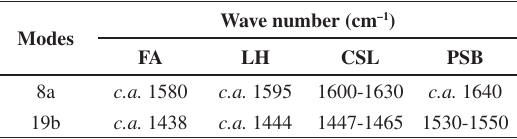
Table 2. Pyridine bands adsorbed on the solid surface according Benvenutti et al. 23 and Akçay 11 .